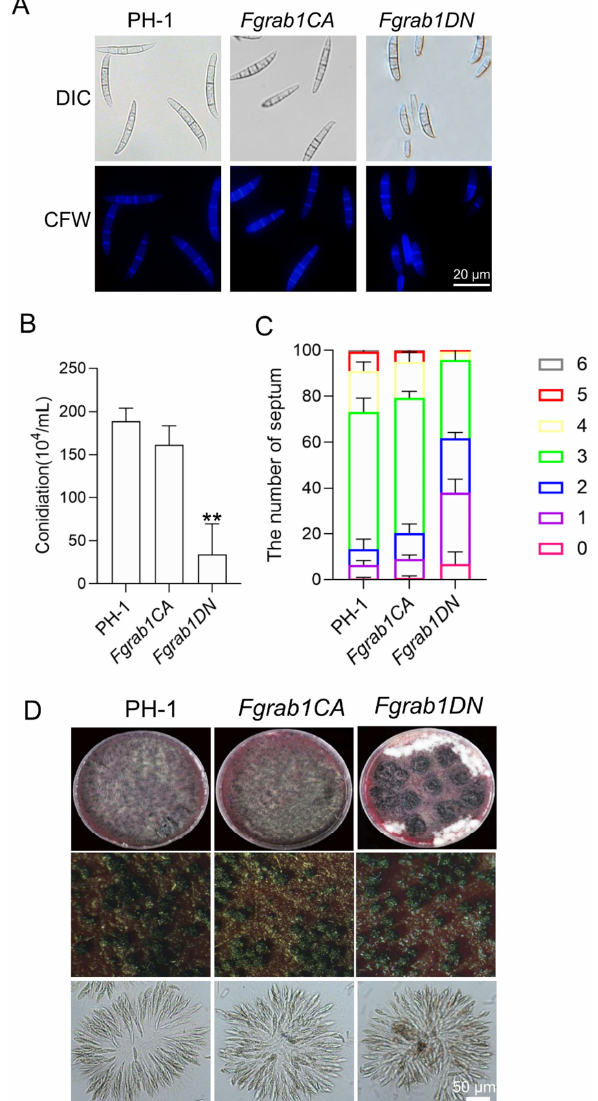
Figure 3. FgRab1 inactivation perturbs conidiation but not sexual reproduction in F. graminearum . ( A ) Conidial morphology of the wild-type PH-1, Fgrab1CA and Fgrab1DN strains, bar = 20 µ m. ( B ) Conidia formation by the wild-type PH-1, Fgrab1CA and Fgrab1DN strains. Error bars represent SD from three replicates, and two-tailed Student’s t -test was used for paired comparison of the conidiation between PH-1 vs. Fgrab1CA and Fgrab1DN strains (**, p < 0.01). ( C ) The number of conidia septa of the indicated strains. Error bars represent SD from three replicates, which was used for paired comparison of the number of conidial septum between PH-1 vs. Fgrab1CA and Fgrab1DN . ( D ) Perithecia and ascospore formation by the indicated strains, bar = 50 µ